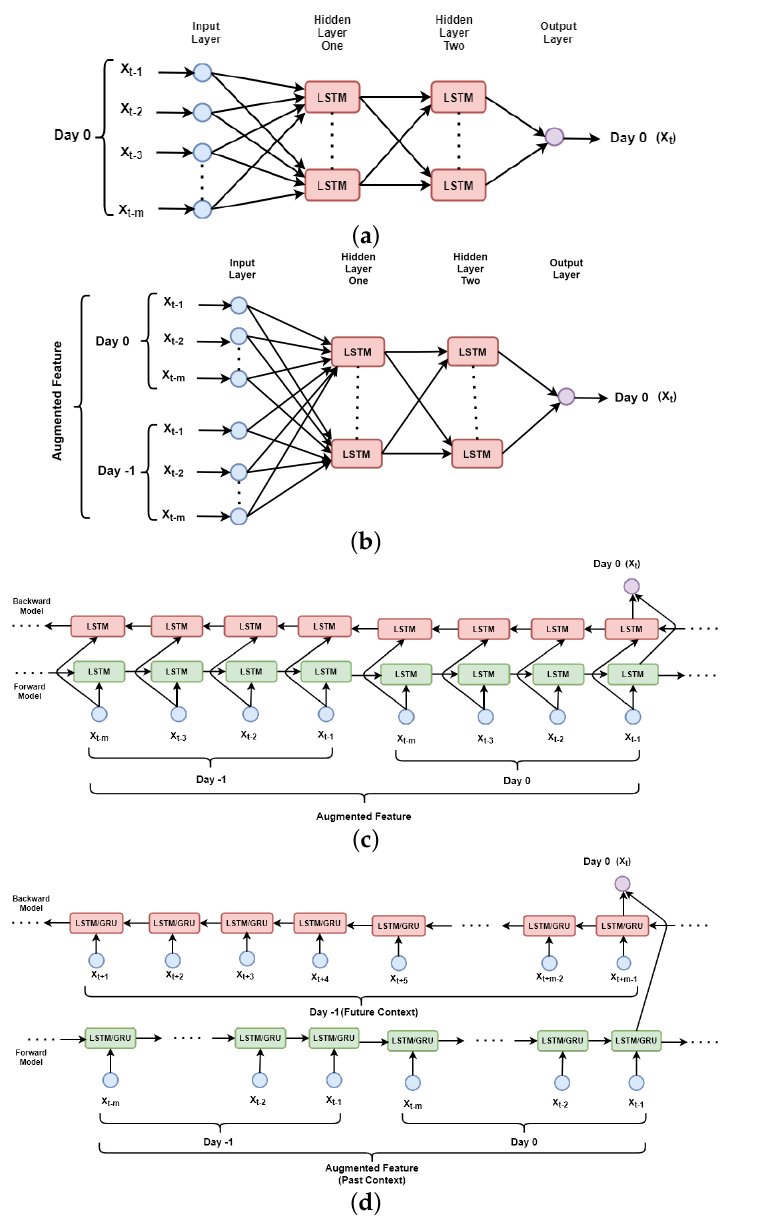
Figure 3. Schematic diagram of ( a ) ULSTM ( b ) M-ULSTM ( c ) BLSTM ( d )